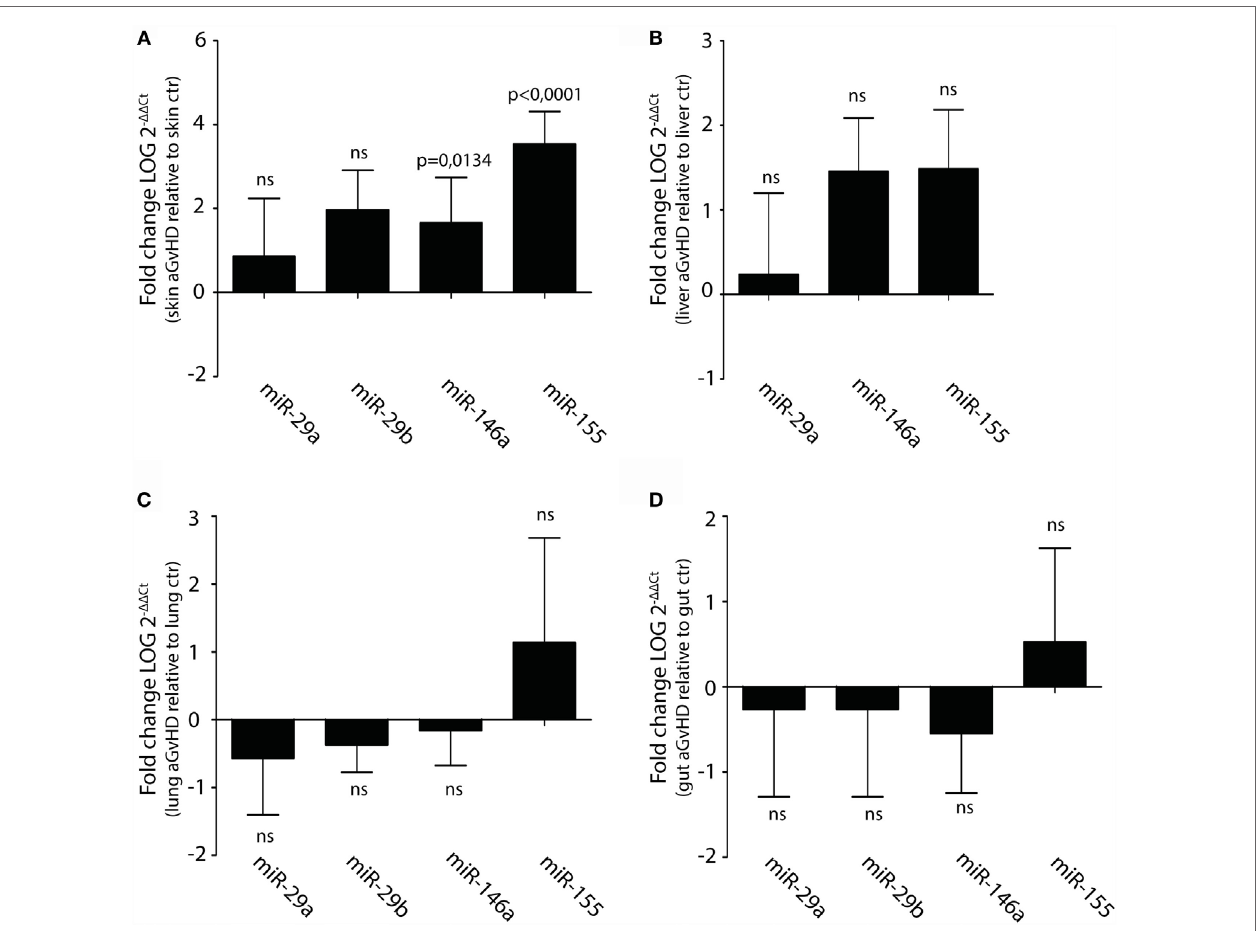
FigUre 4 | Upregulation of mir-146a and mir-155 in skin but not liver, lung, and intestines during agvhD . qRT-PCR analysis of miRNA expression in (a) skin (controls, n = 6; aGvHD, n = 6), (B) liver (controls, n = 6; aGvHD, n = 6), (c) lung (controls, n = 6; aGvHD, n = 6), or (D) intestines (controls, n = 6; aGvHD, n = 6). Samples were normalized to endogenous controls and expression levels reported as log of 2 −ΔΔ Ct ± SD. Significance was calculated using the Student’s t -test (two-tailed) with Welch’s